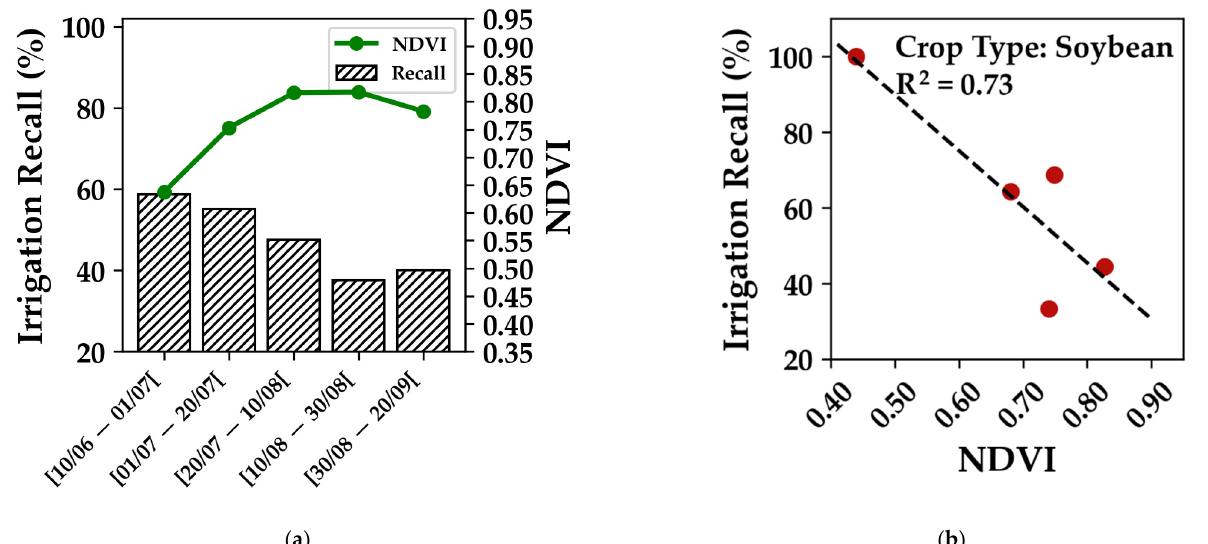
Figure 4. ( a ) Dynamics of recall in function of NDVI for Soybean crops between September and June. Recall values as bar dashed plots with NDVI in green line; ( b ) recall values plotted against NDVI values. Each point corresponds to the average recall and NDVI, respectively, for the 20-day time interval between June and September.